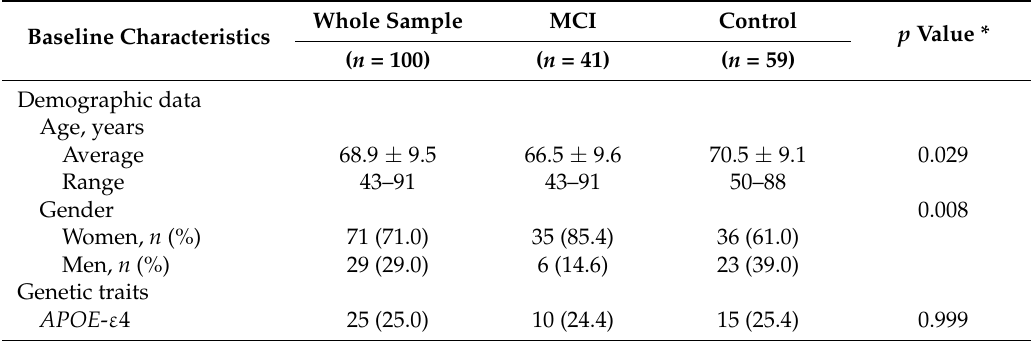
Table 1. Baseline characteristics of the selected sample according to individuals with mild cognitive impairment and normal